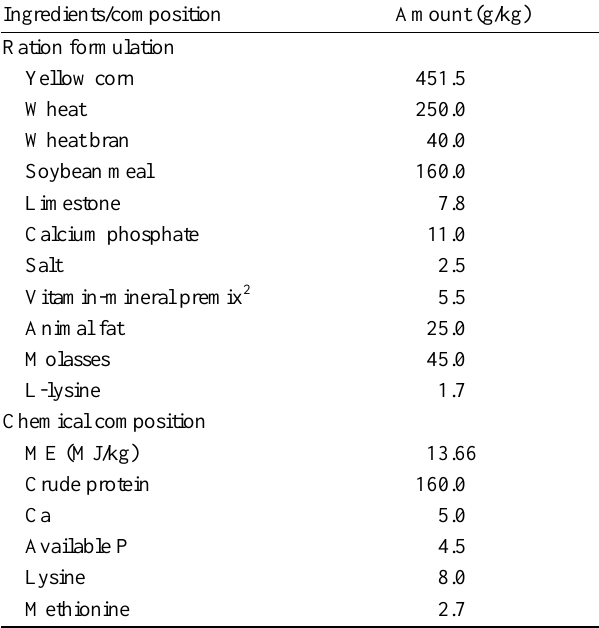
Table 1. Feed composition of basal diet fed to uncastrated growing-finishing swine